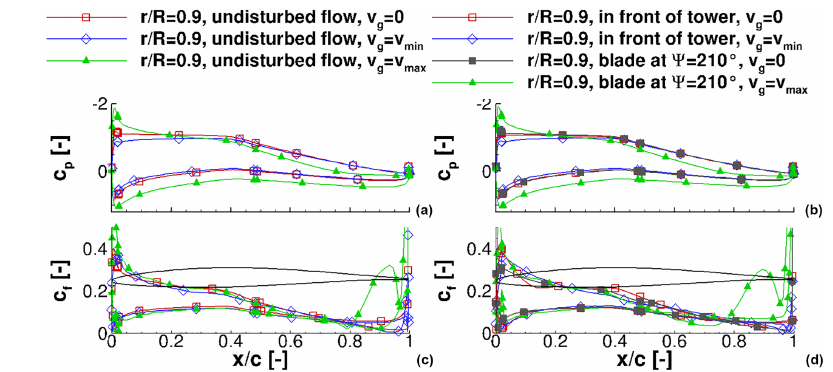
Figure 10. Pressure distribution of the blade at the outboard section, (a, c) undisturbed flow, and (b, d) with tower blockage; (a, b) pressure distribution and (c, d) friction force coefficient.